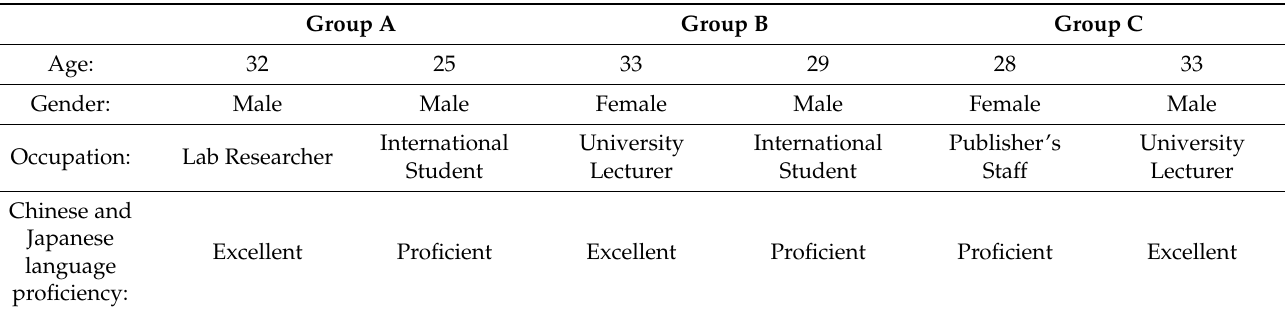
Table 10. The specific information of the human